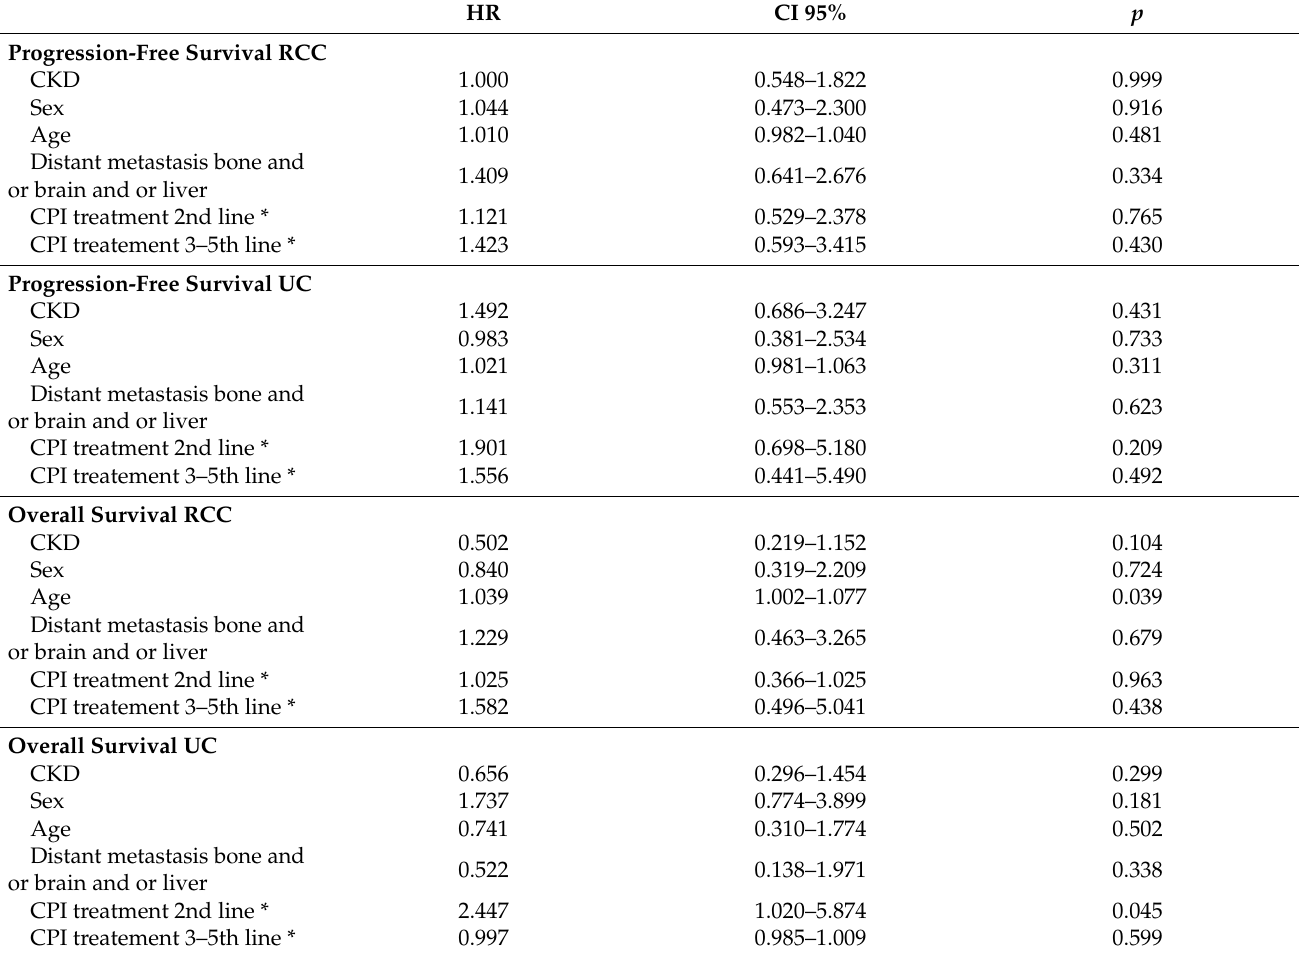
Table 7. Results of a multivariate Cox regression analysis of patients with and without CKD. CKD = chronic kidney